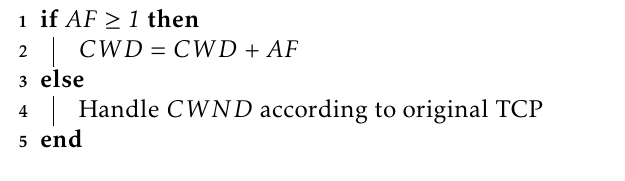
Figure 3. Window adaptation